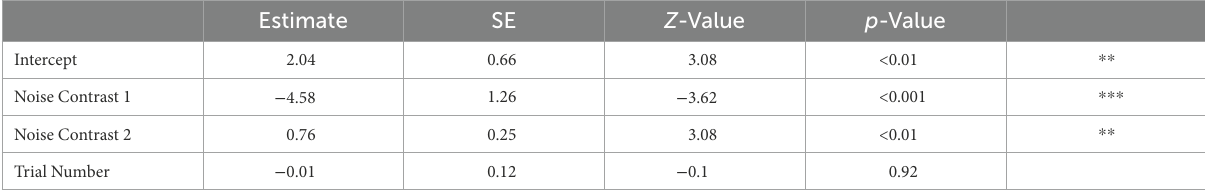
TABLE 6 Model outcomes for the subset of vowels.